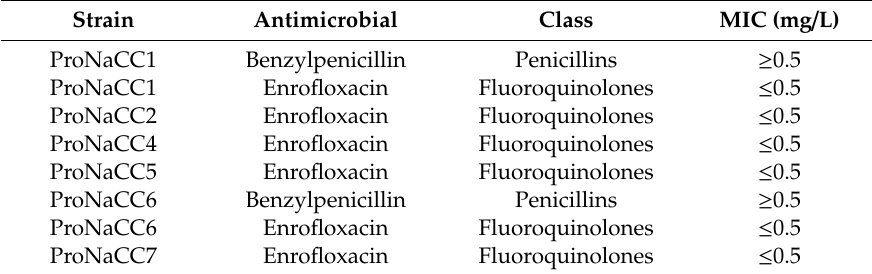
Table 4. Detected resistance to antimicrobials among the strains included in this study.